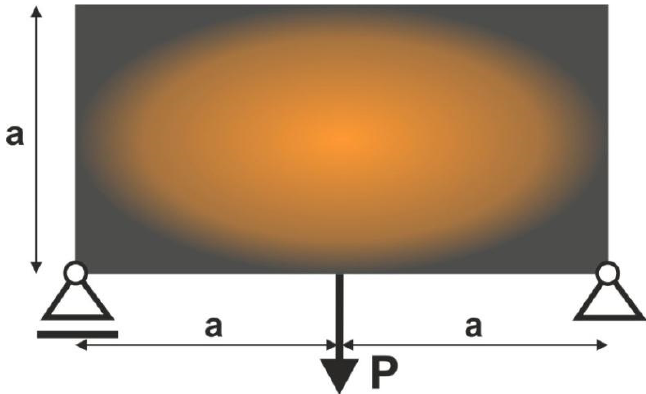
Figure 6. The rectangular structure with applied load and support.